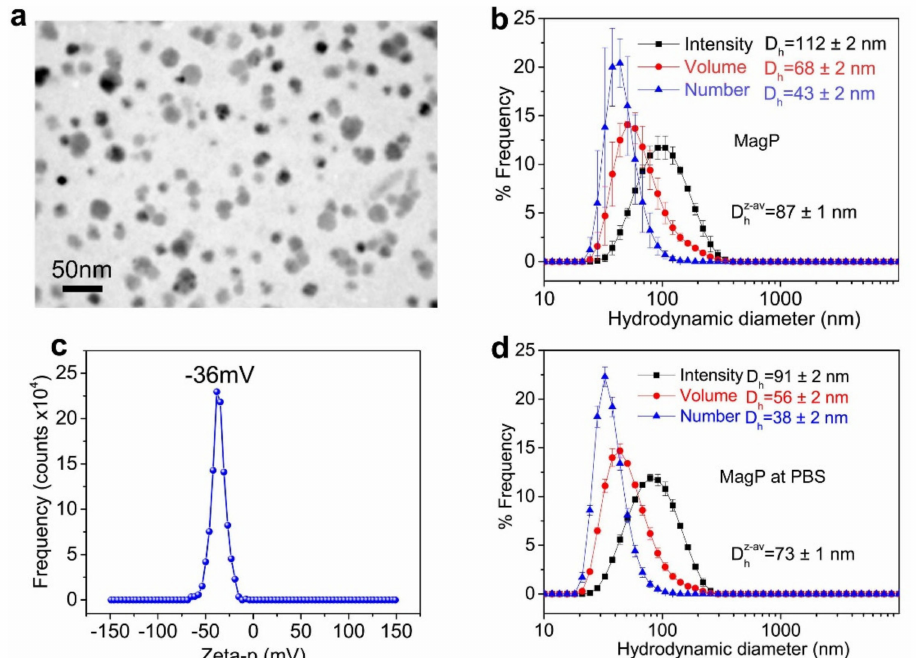
Figure 2. ( a ) TEM image; ( b ) hydrodynamic diameter distributions from DLS measurements; ( c ) zeta- potential distribution for the MagP nanoparticles; ( d ) hydrodynamic diameter distributions from DLS measurements for the MagP-NODAGA functionalized MIONs. The lower D h of MIONs in PBS is attributed to the contraction of the polyelectrolyte chains due to the high